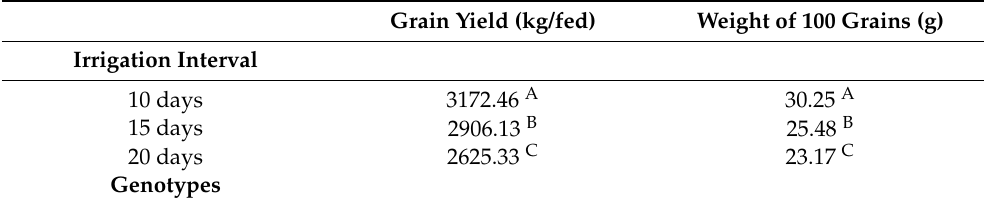
Table 4. Yield parameters of five maize genotypes as affected by normal (10 days), mild (15 days), and severe (20 days) water stress at the vegetative stage. Means within the same column distinguished by different letters differ significantly according to the Tukey’s posthoc HSD test at p = 0.05. Grain Yield